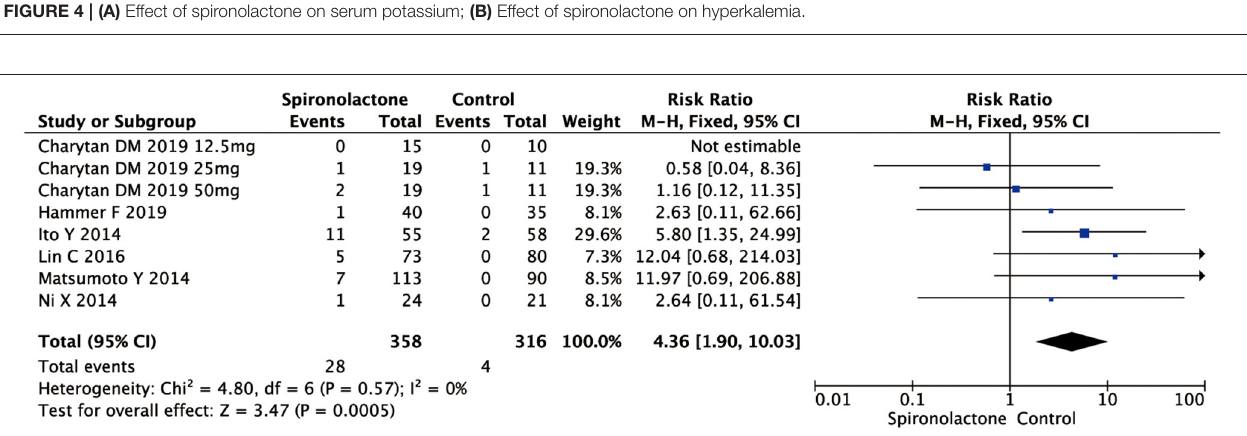
FIGURE 5 | Effect of spironolactone on GYN. GYN, gynecomastia.